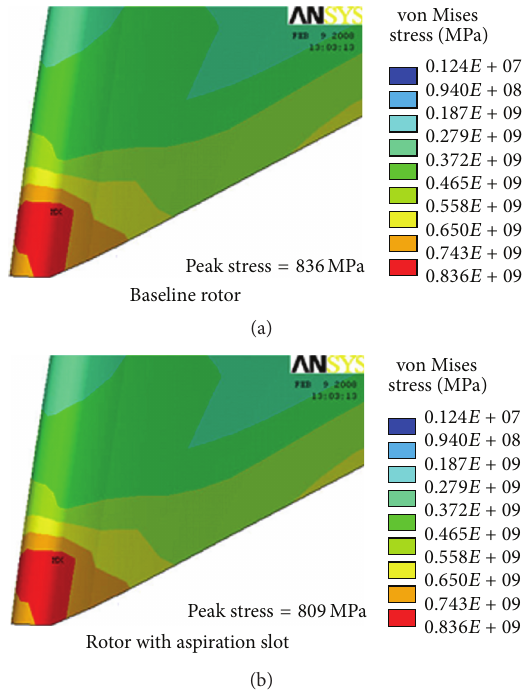
Figure 19: von Mises stress distribution in the hub region of the rotorbladewithoutandwithaspiration(AR37-2)atdesignmassflow rate showing the location of peak